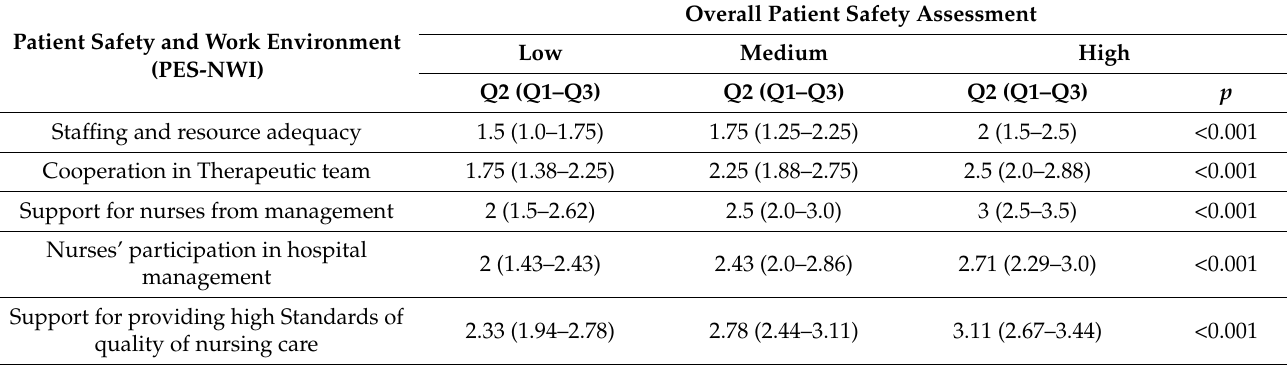
Table 1. Characteristics of work environment (PES-NWI) across overall patient safety assessment.